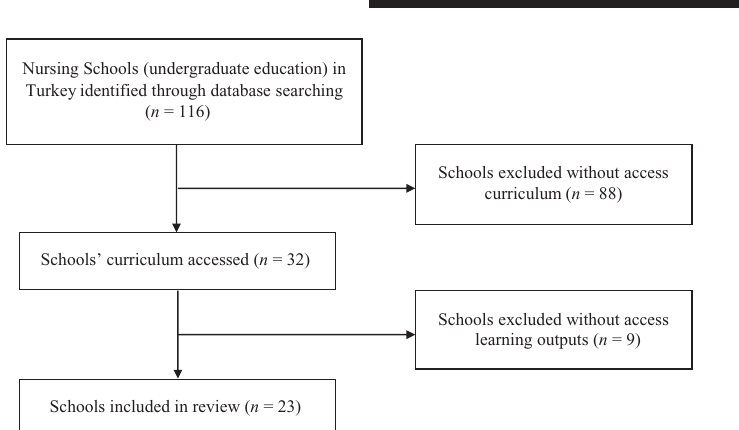
Figure 1. The flow chart of the selection criteria.